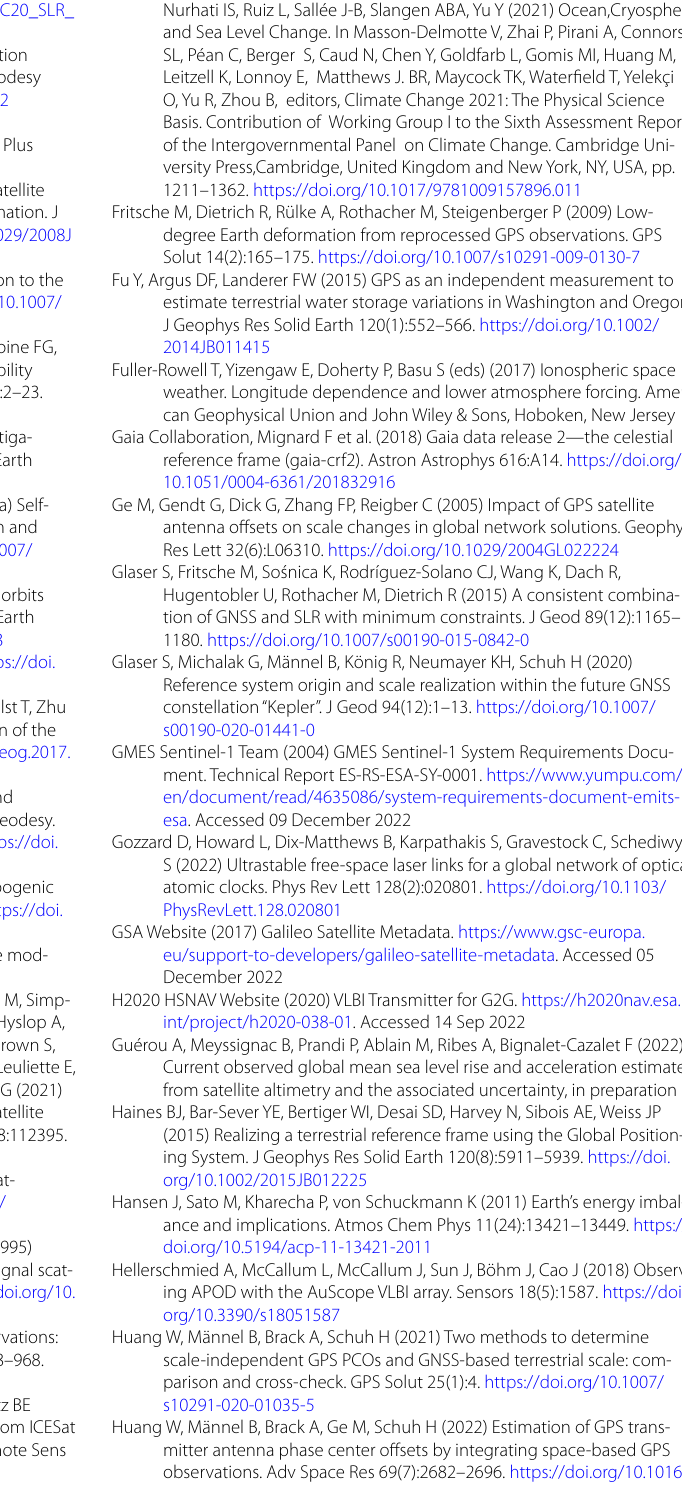
figure axis orientation. J Geod 94(12):113. https:// doi. org/ 10. 1007/ s00190‑ 020‑